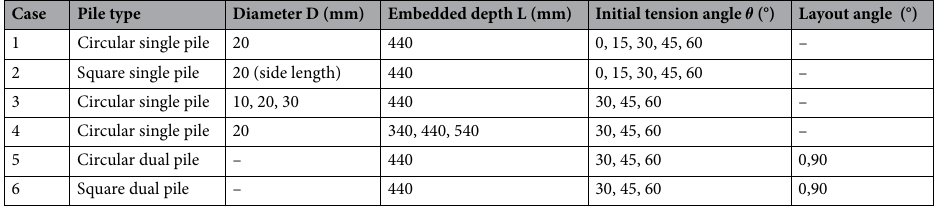
Table 2. Experimental